Question: Write a descriptive caption for this figure.
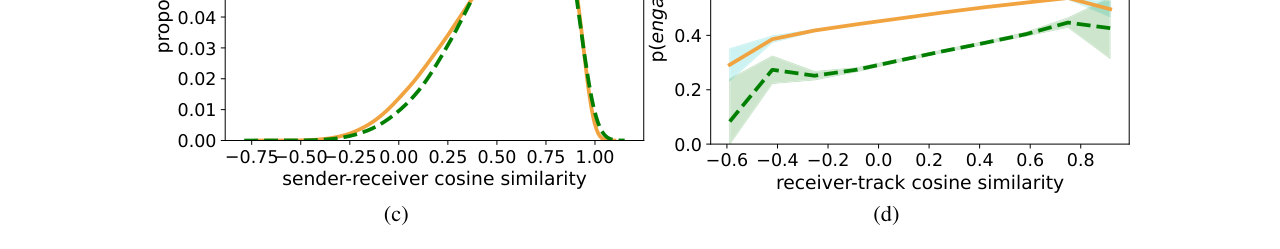
Answer: Effects of reciprocity (a-b) and share media type (c-d) on the probability of becoming engaged with the artist: (a) Distribution of sender-receiver cosine similarities in our sample, separated by reciprocal and non-reciprocal tie. (b) Probability of engagement following link share as a function of receiver-track cosine similarity, separated by reciprocal and non-reciprocal tie. (c) Distribution of sender-receiver cosine similarities in our sample, separated by direct or broadcast application. (d) Prob- ability of engagement following link share as a function of receiver-track cosine similarity, separated by direct or broadcast application.